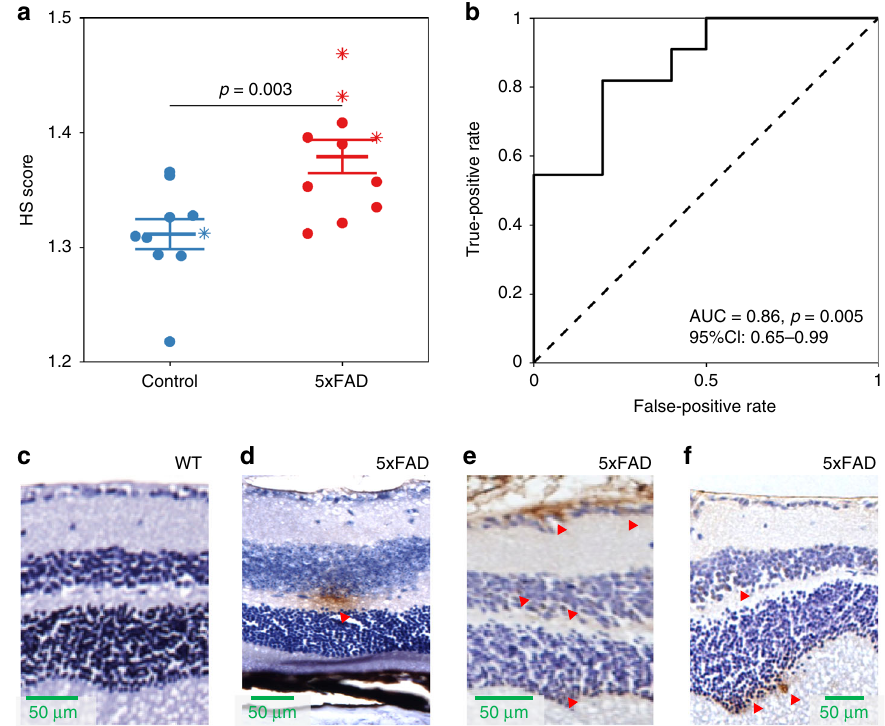
Fig. 7 5xFAD retinal HS imaging validates human fi ndings. Mouse retinal hyperspectral (HS) scores were calculated using the recalibrated human spectral model (450 – 680 nm). a HS scores were signi fi cantly different for control (blue, n = 10) and 5xFAD mice (red, n = 11; mean ± SEM). The markers